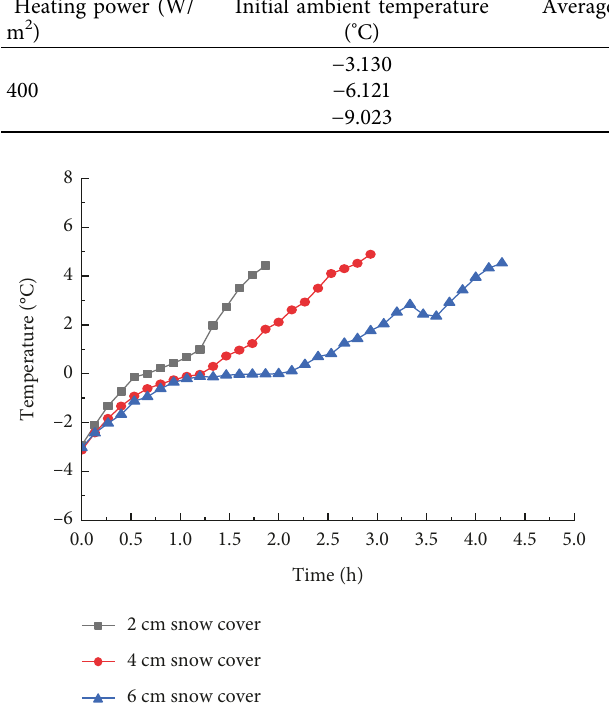
Figure 7: Curves of surface temperature changes of specimens with different snow